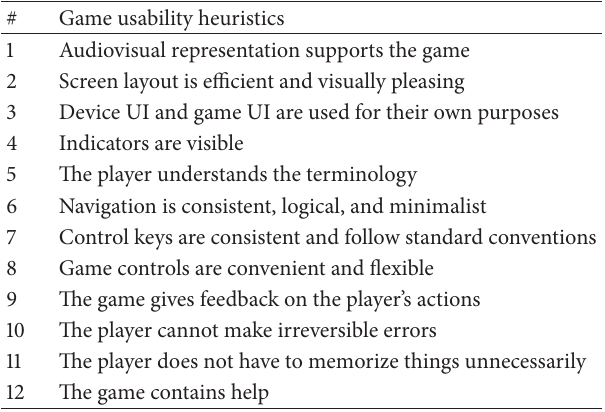
Table 7: The statements used in questionnaire to evaluate usability.